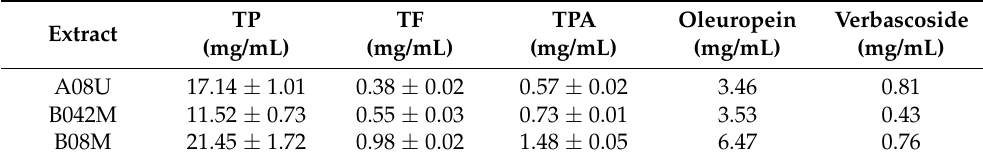
Table 4. Phytochemical composition of the prepared